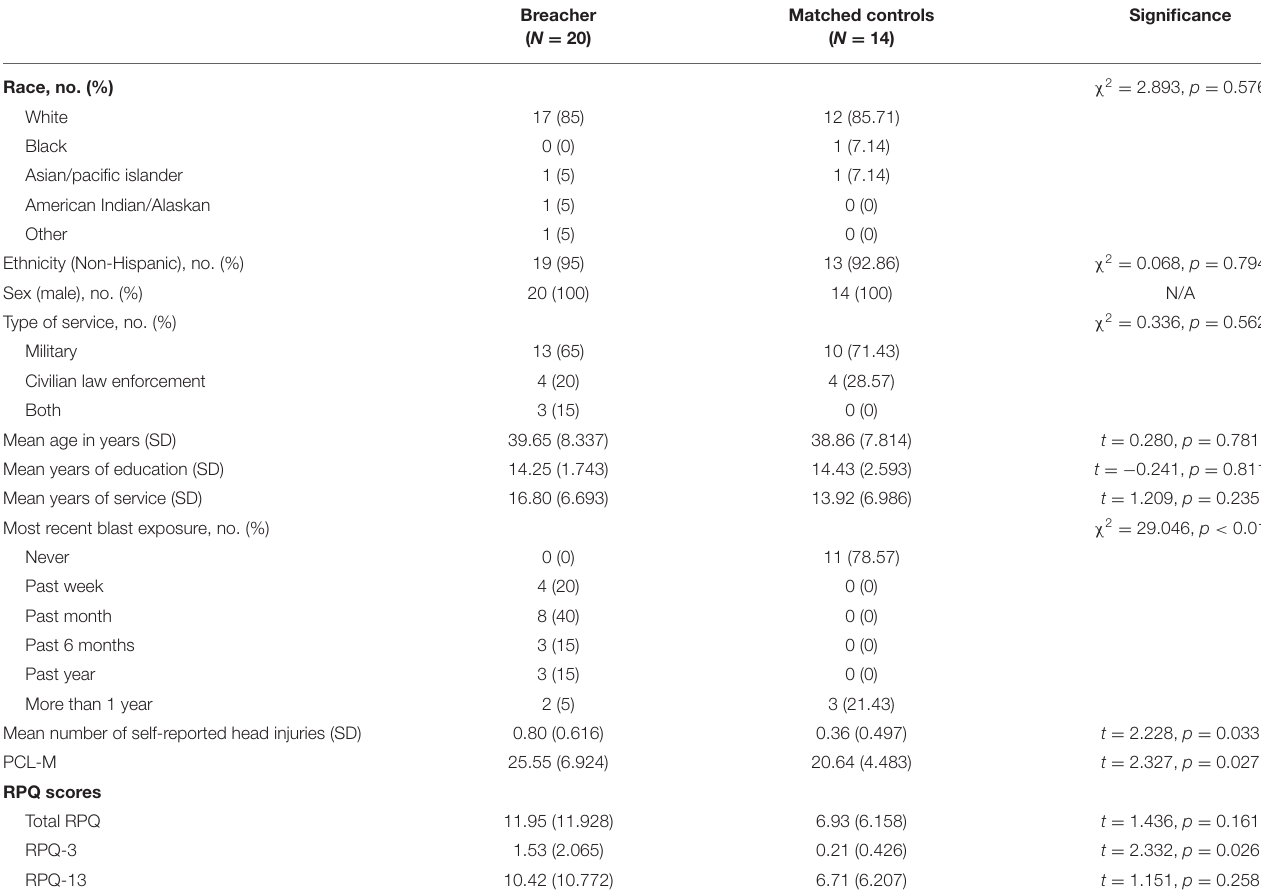
TABLE 1 | Demographic and clinical